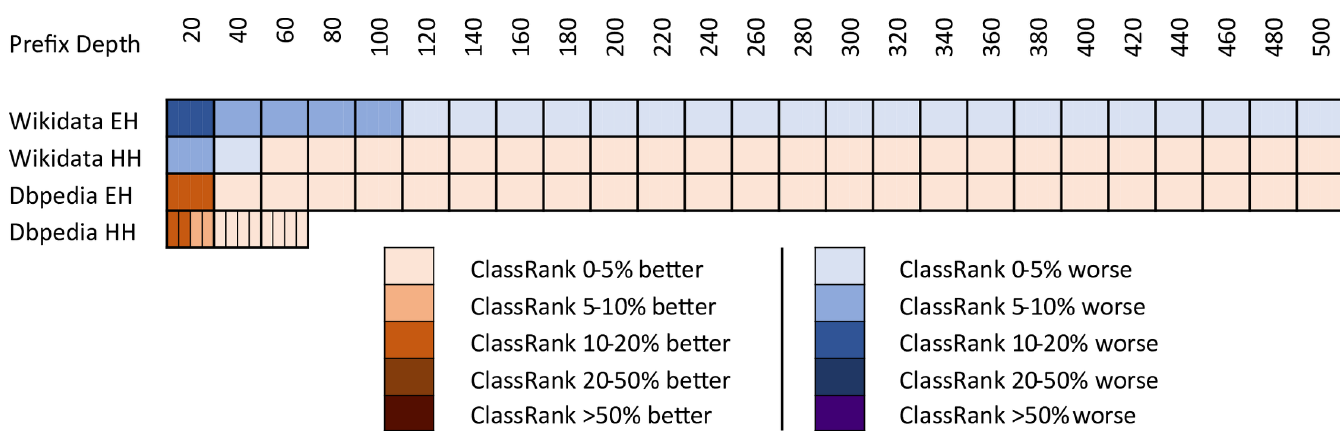
Fig 7. Performance comparison of ClassRank against Adapted ClassRank at every source and prefix depth.